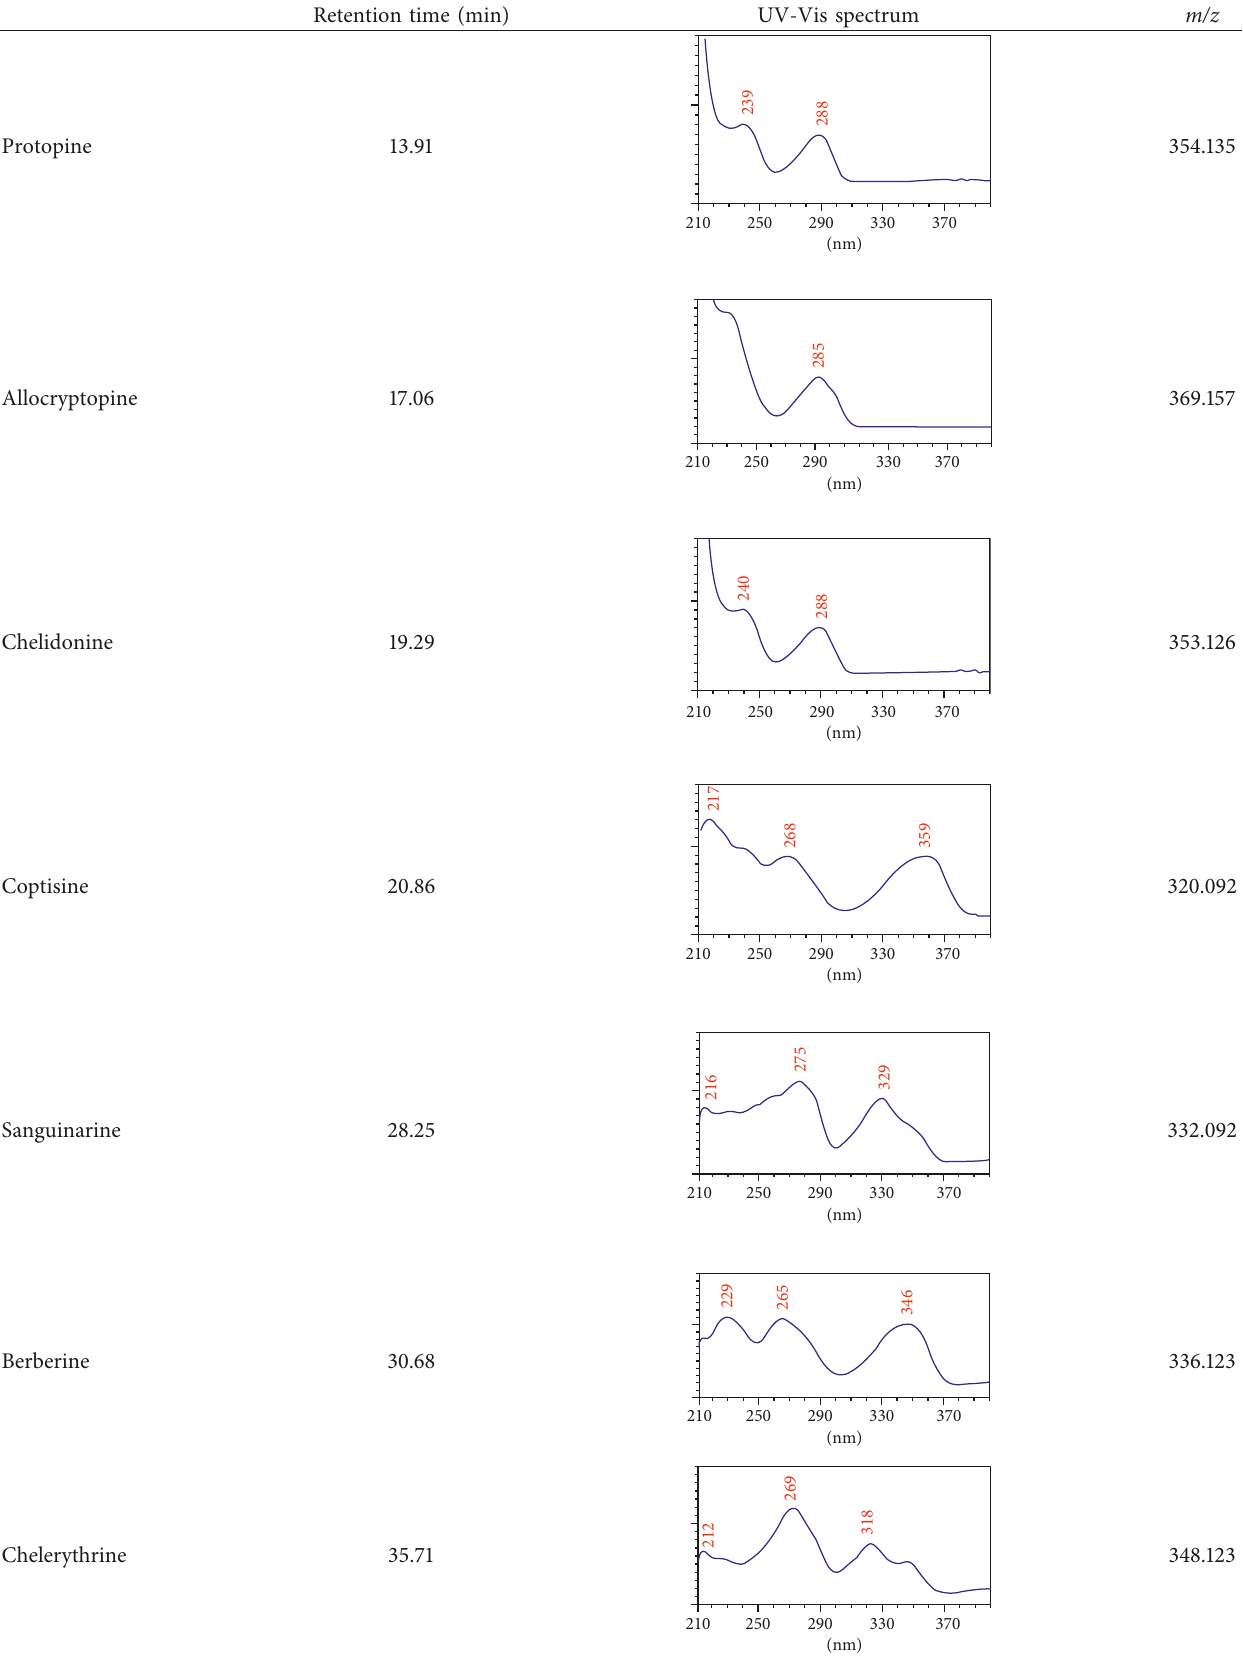
Table 3: The data used for identification of the investigated